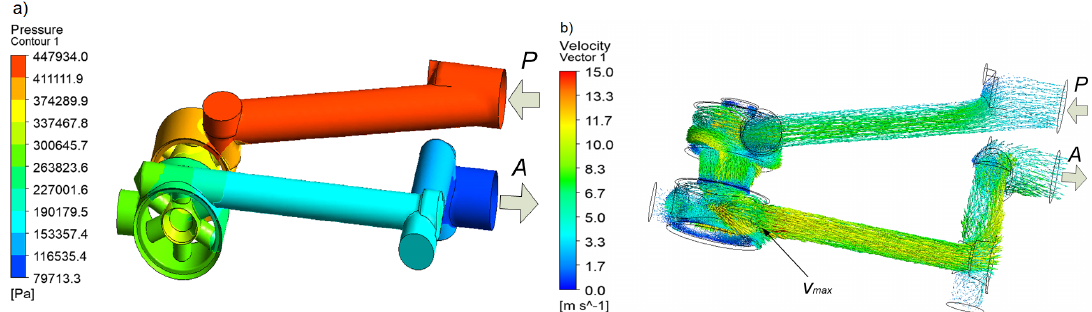
Figure 10. Simulation results obtained with the P − A flow path at a flow rate Q = 10 dm 3 min − 1 :